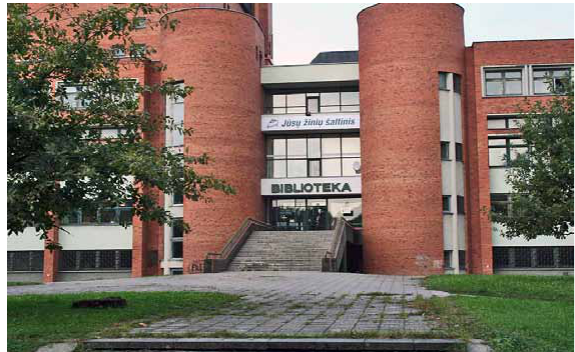
Fig. 1. Main entrance of the Kaunas County Public